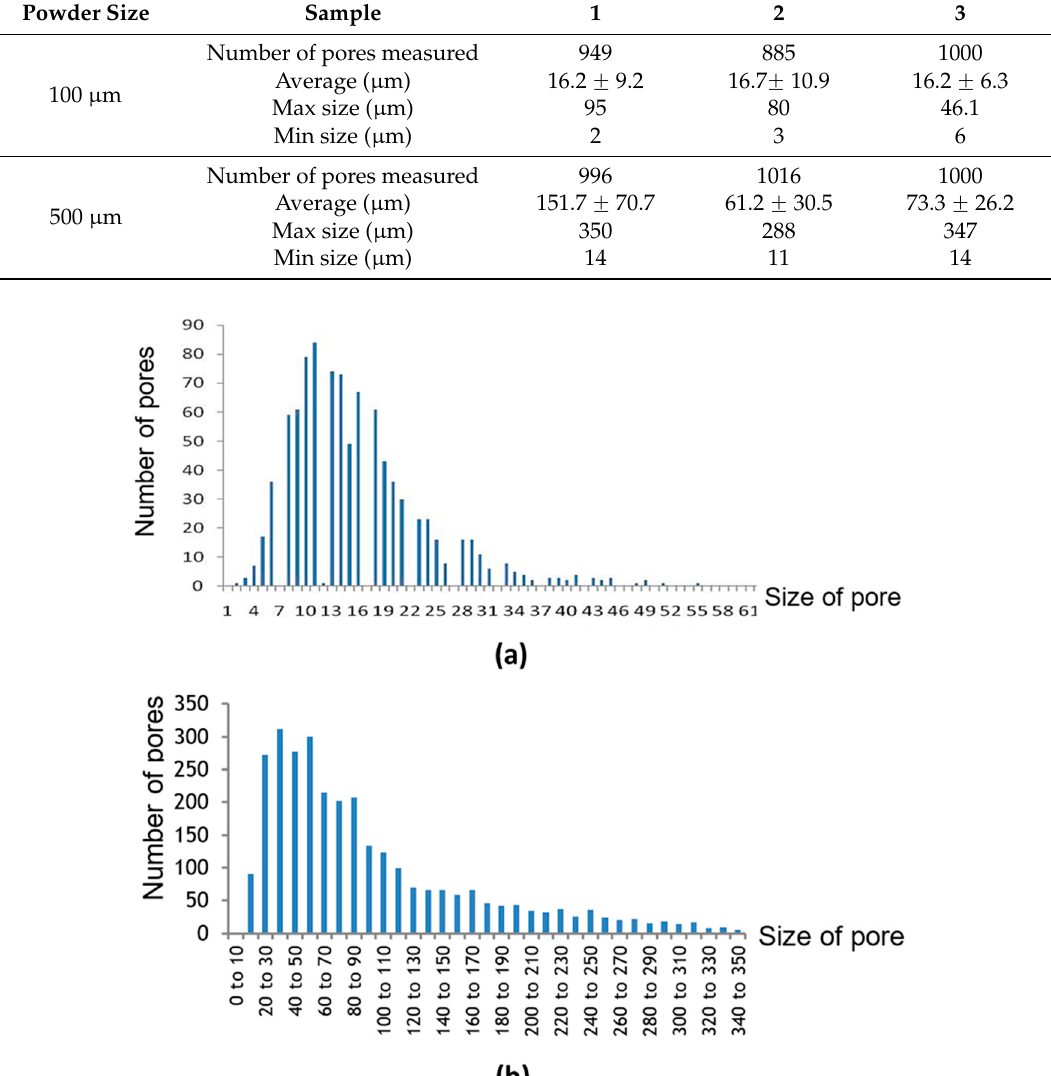
Figure 5. Pore size distribution of ( a ) membranes made from 100 µm powder ( b ) membranes made from 500 µm powder.